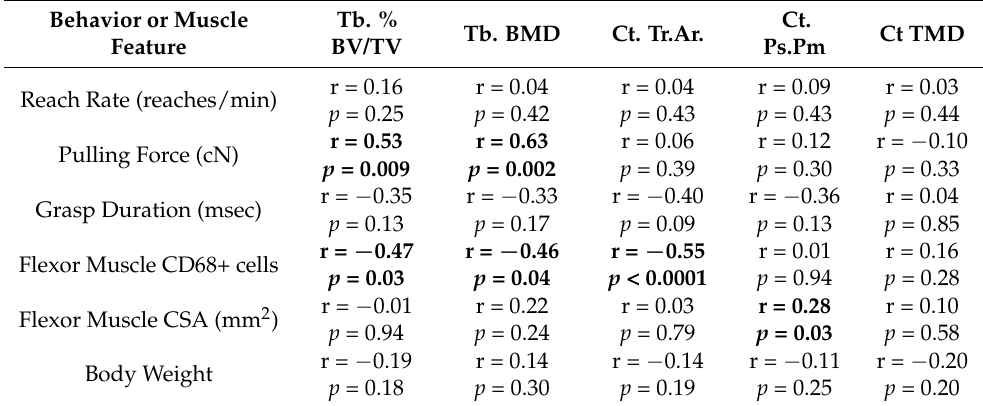
Table 2. Correlations of behavior and muscle features with key radial bone trabecular and cortical bone microstructural attributes. Significant findings are bolded.